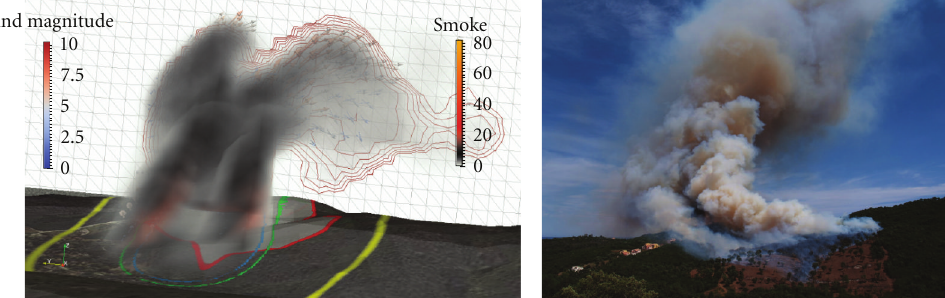
Figure 11: Case 2: Simulated and observed plume. Simulated plume is given 50 minutes after ignition (the blue contour represents the fire front at that time) with observation taken approximately at the same time.